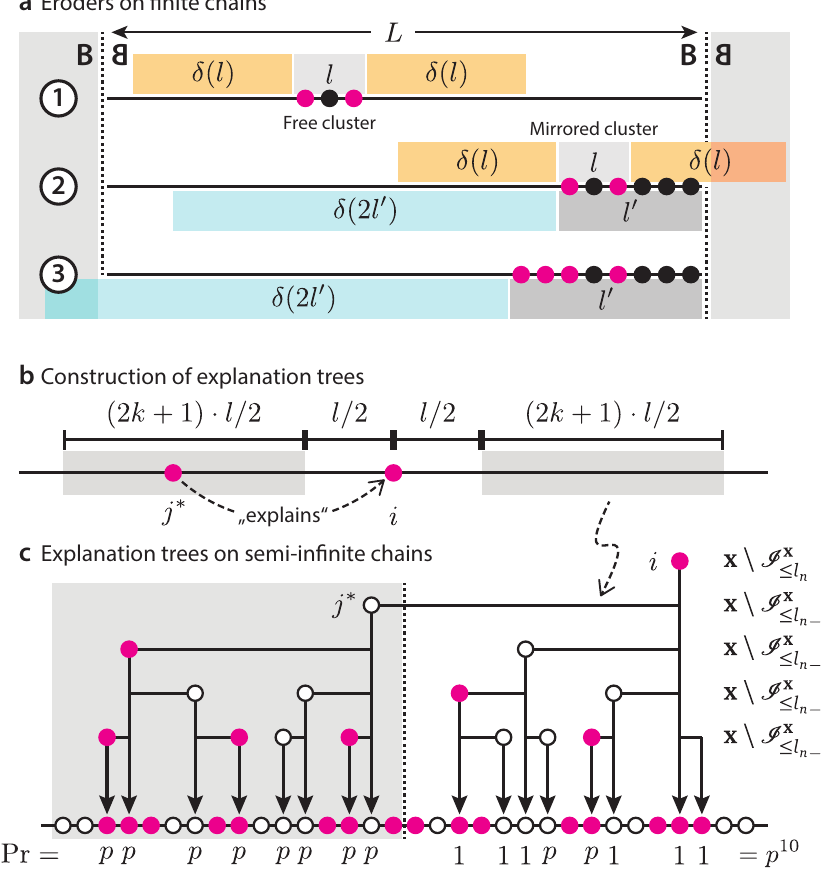
Figure 12: Proofs. a Eroder property for a finite system with mirrored boundary conditions. Errors in the cluster I are marked red. Without loss of generality, I can be made contiguous by padding holes with additional errors (black). An explanation is given in Appendix C. b Illustration of the implication in Eq. (131b): An element i ∈ x \ (cid:73) x requires the existence of ≤ l another element j ∗ ∈ x \ (cid:73) x in a specific range given by k and l . c Explanation tree on the ≤ l − 1 semi-infinite chain with mirrored boundary condition. Cells in state 0 (1) are marked white (red). The probability to realize the shown explanation tree by a mirrored Bernoulli process (cid:55) with rate p = p is labeled by Pr. Note that the shown error pattern (red) fails to realize 0 this explanation tree (arrows) since some explanatory sites are empty. Details are given in Appendix